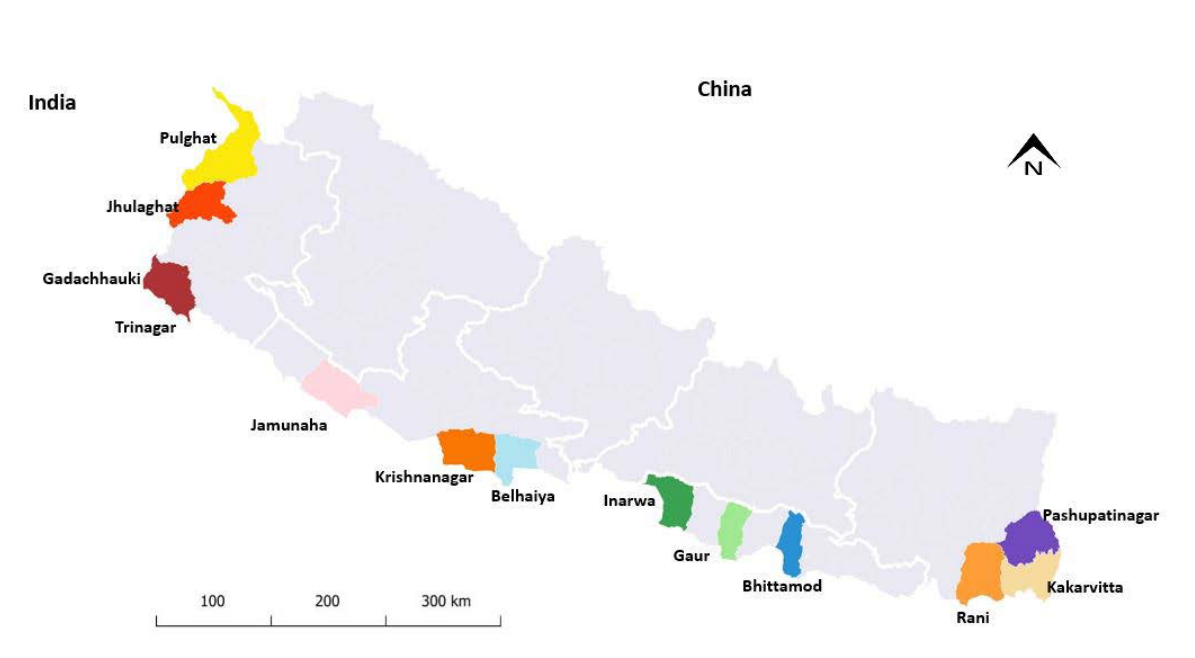
Figure 1. Map of Nepal showing ground crossing points of entry (POE) between Nepal and